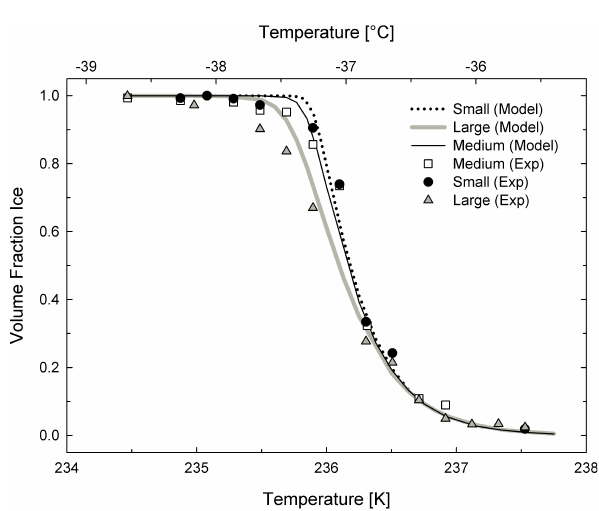
Fig. 13. Comparison of modelled volume fraction frozen curves for each droplet size with experimental (exp)